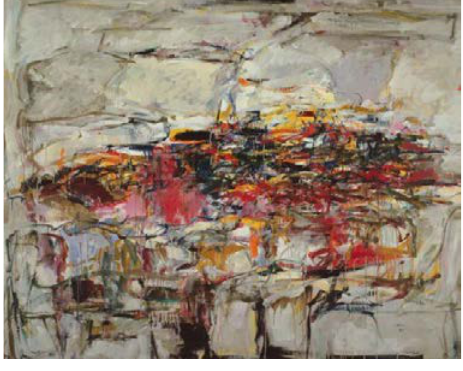
Fig. 15 City Landscape 1955 oil, canvas